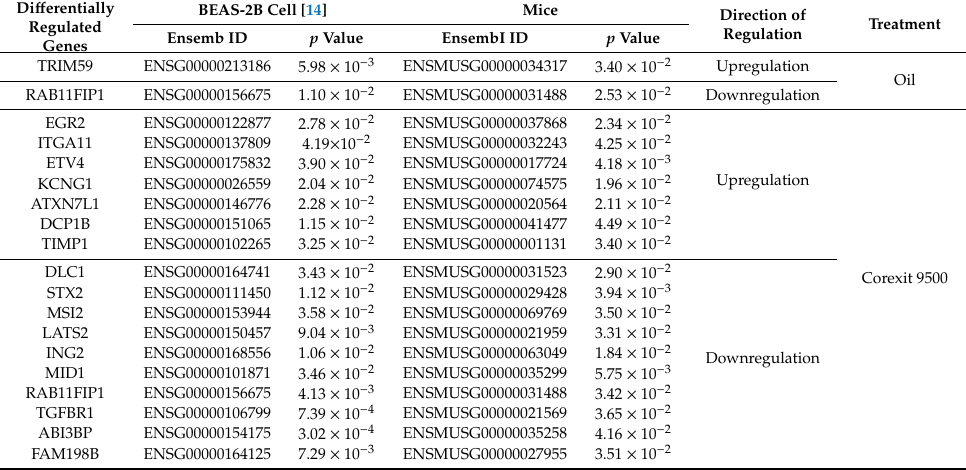
Table 6. Comparison between this study and RNA-seq analyses of a treated human airway epithelial cell line (BEAS-2B) [13] at gene